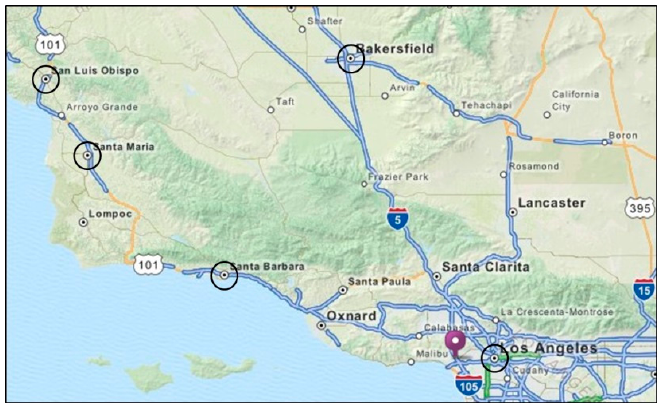
Figure 2. Map of Los Angeles VA Medical Center (hub) and affiliated VA Community-Based Outpatient Clinics (spokes): San Luis Obispo (360 miles), Santa Maria (300 miles), Santa Barbara (200 miles) and Bakersfield (210 miles). Note: map and round-trip driving distances (from CBOCs to Los Angeles) derived from